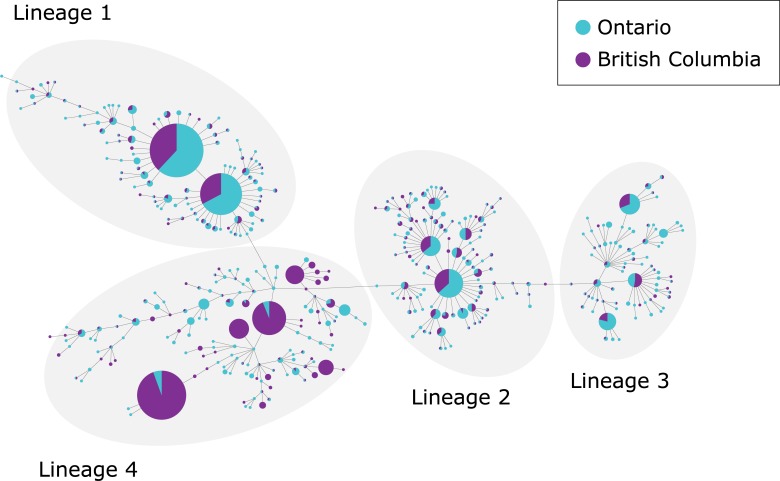
Minimum spanning tree analysis of 24-locus MIRU-VNTR of the 1,894 intra- and interprovincially clustered isolates with lineage indicated, Ontario and British Columbia (2008–2014).The size of each circle is proportional to the number of isolates. Classification of genotypes by province is visualized by colour coding.